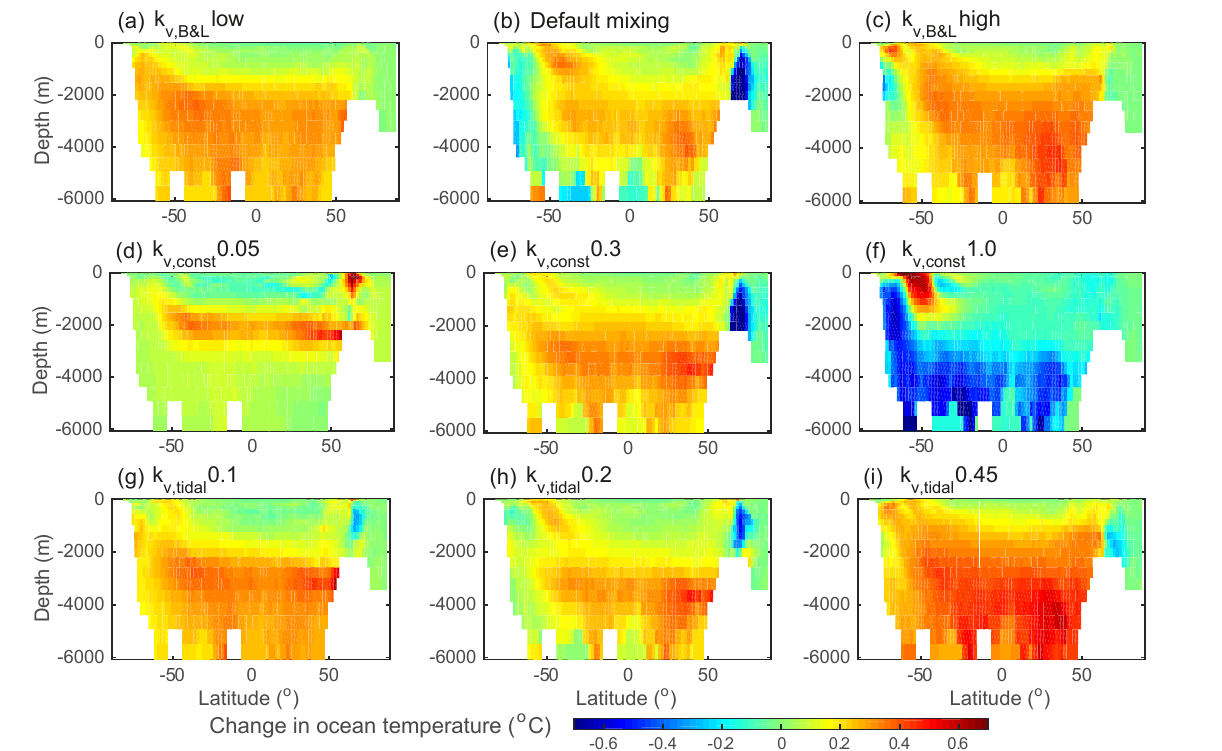
Figure 3. Zonal average change in ocean temperature for year 1100 relative to year 0 for the different model versions. Each row shows results for one mixing scheme (Bryan and Lewis mixing, constant mixing, tidal mixing in the first, second, and third row respectively), with vertical diffusivity increasing from left to right.